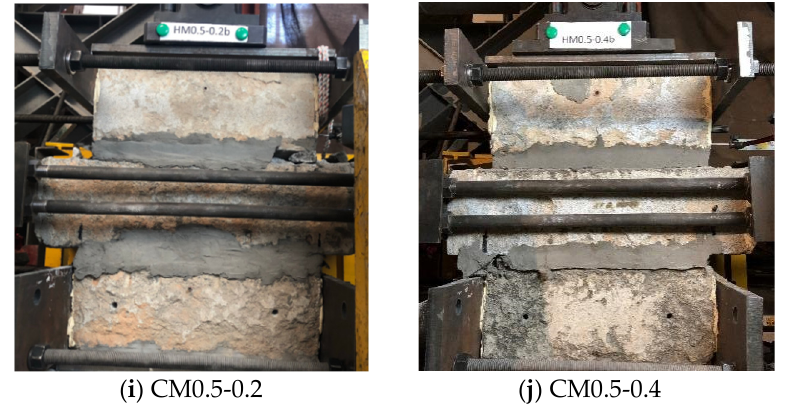
Figure 9. Final damage state of specimens after the test: ( a ) M-0.2, ( b ) M-0.4, ( c ) PM-0.2, ( d ) PM-0.4, ( e ) ECC-0.2, ( f ) ECC-0.4, ( g ) CM0.3-0.2, ( h ) CM0.3-0.4, ( i ) CM0.5-0.2 and ( j ) CM0.5-0.4.